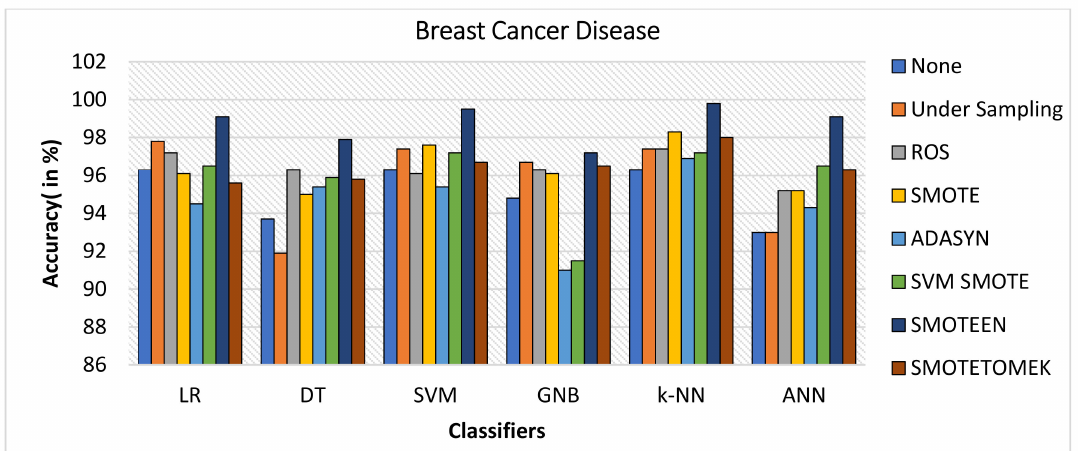
Figure 6. Accuracy for breast cancer disease dataset of balancing algorithms over six classifiers: Logistic regression (LR), Decision tree (DT), Support vector machine (SVM), Gaussian Naïve Bayes (GNB), k-Nearest Neighbor(k-NN), Artificial Neural Network (ANN), Random oversampling (ROS), Synthetic Minority Oversampling Technique (SMOTE),Adaptive Synthetic (ADASYN), SMOTE- Edited Nearest Neighbor (SMOTEEN).